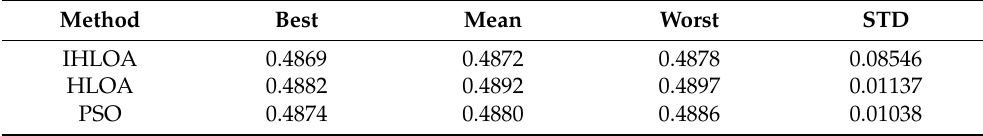
Figure 6. Convergence curve of allocation of two PV in 69-bus distribution system in the deterministic case. Table 1. Statistical Analysis of algorithms performance for allocation of PVs in deterministic approach in 33-bus system.